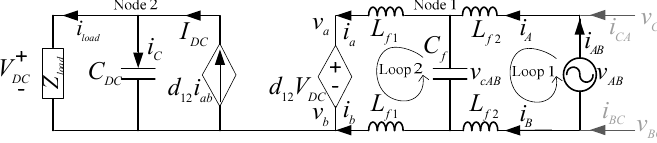
Table 1. Switching states for the line-to-line 𝑣 (cid:3002)(cid:3003) circuit. Mode